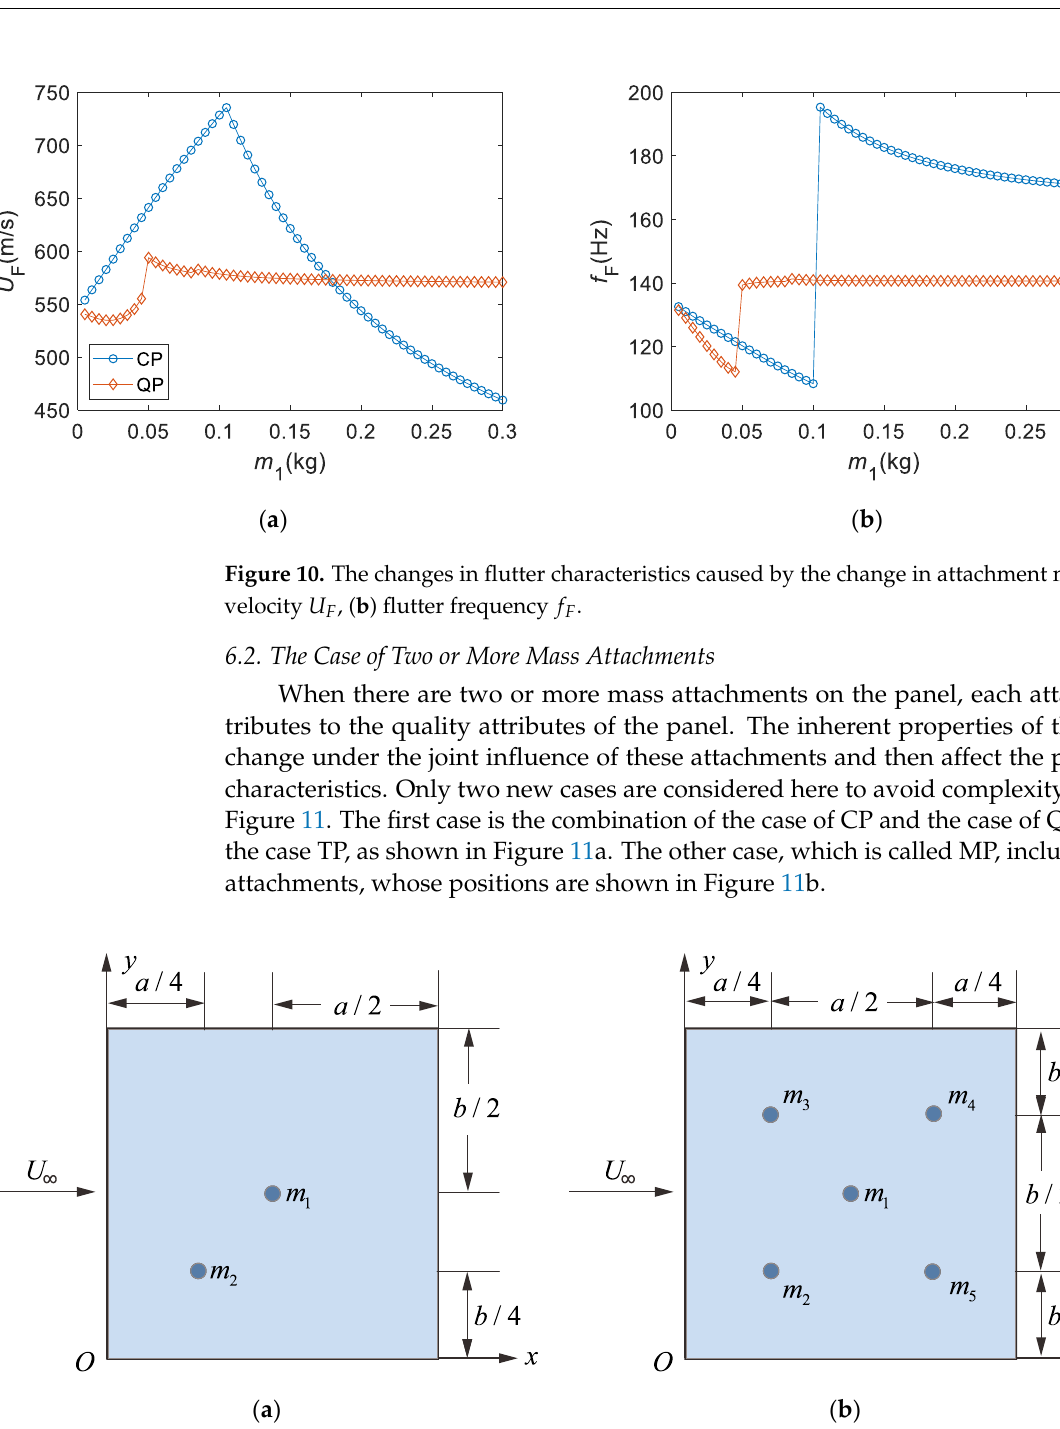
The flutter velocities and flutter frequencies of the panel in the case of TP and MP